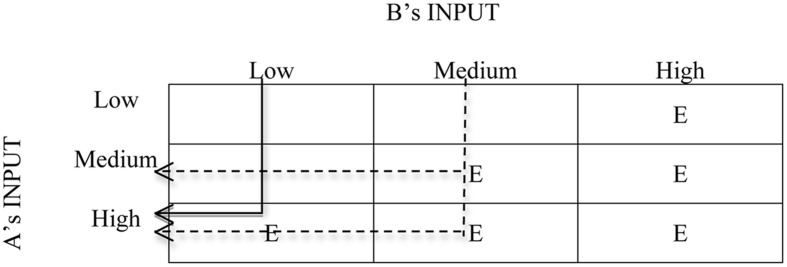
Causal schema for compensatory causes in the form of Kelley (1973). (E = high outcomes for A).